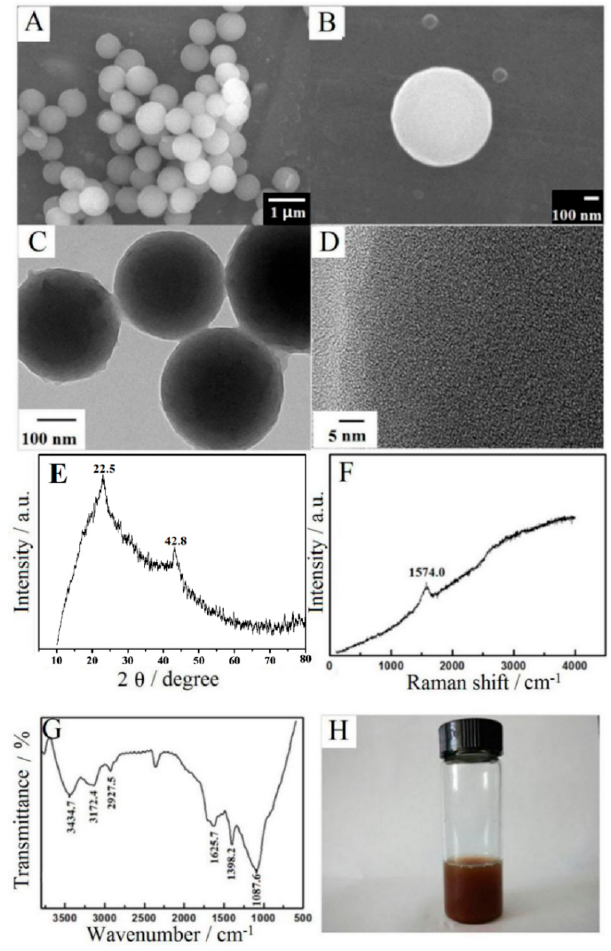
Figure 1. ( A,B ) SEM; ( C,D ) HRTEM; ( E ) XRD; ( F ) Raman spectrum; ( G ) FT-IR spectrum of CMS; ( H ) Photo of 1.0 mg·mL − 1 CMS solution that kept for 2